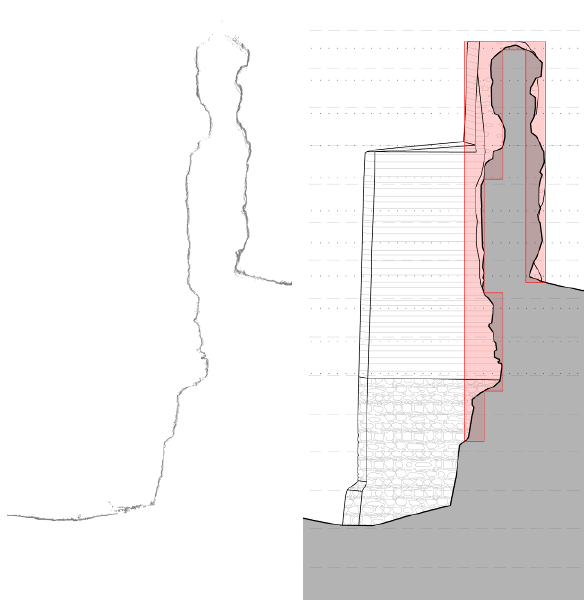
Figure 16. Left: Image showing the geometry of the original earth structure. Right: New intervention